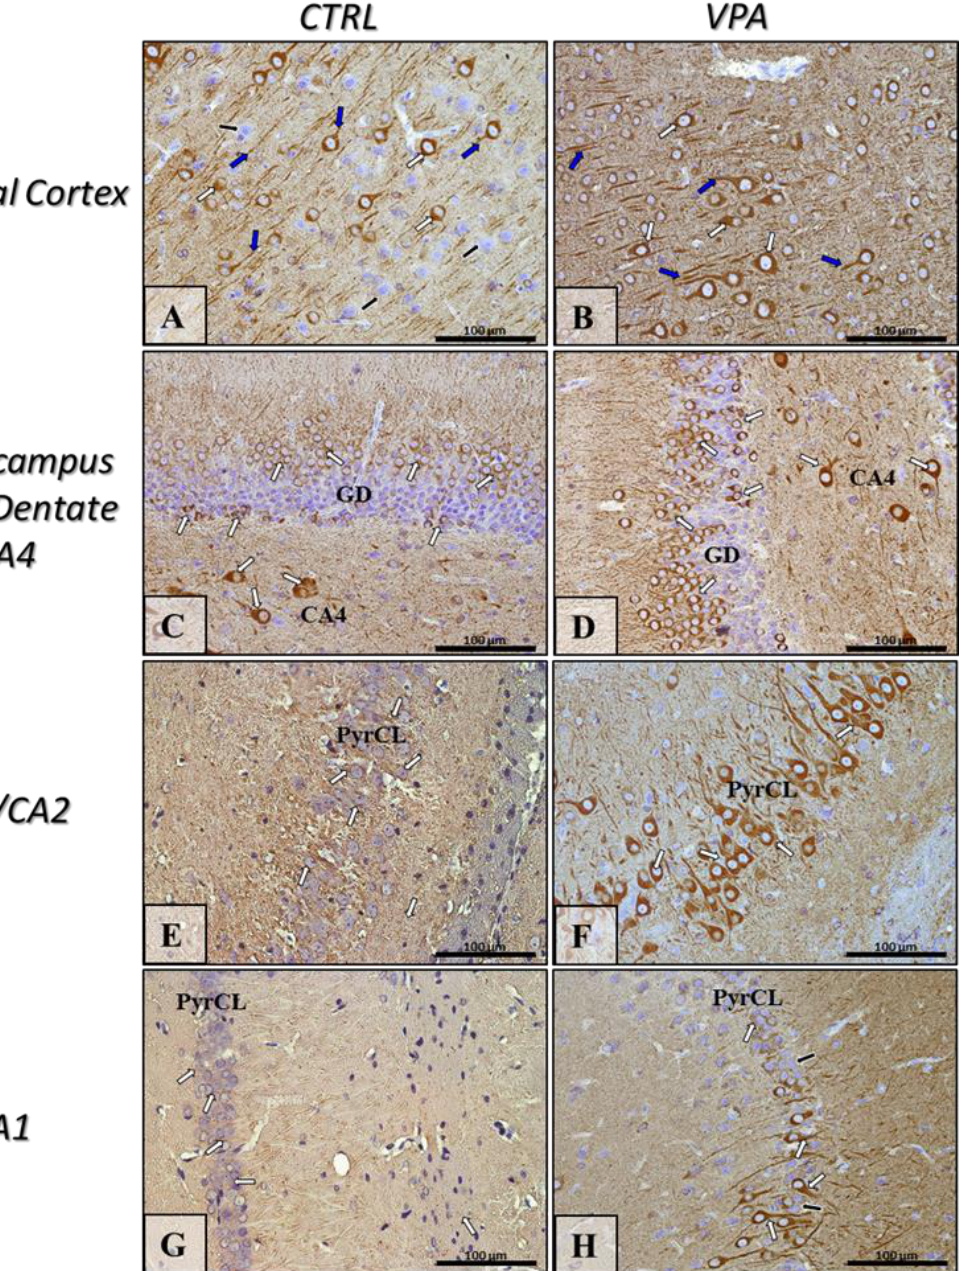
Figure 4. The effect of prenatal exposure to VPA on the immunoreactivity of total Tau protein in the rat brain. Representative microphotography showing immunoexpression of total Tau in the cerebral cortex and hippocampus proper (GD—Gyrus Dentate, CA1-CA4—the regions of Cornu Ammonis) of control rats ( A , C , E , G ) and VPA-treated rats ( B , D , F , H ). IHC reaction. Scale bar: 100 µ m (objective magnification × 40). Tau-immunopositive perikaryons (white arrows) and their processes (blue arrows); black arrows—Tau-immunonegative cells; PyrCL—Pyramidal Cell Layer of CA1-CA3 regions. Representative pictures from n = 11 (CTRL) and n = 9 (VPA) independent experiments in both the hippocampus and cerebral cortex are presented.